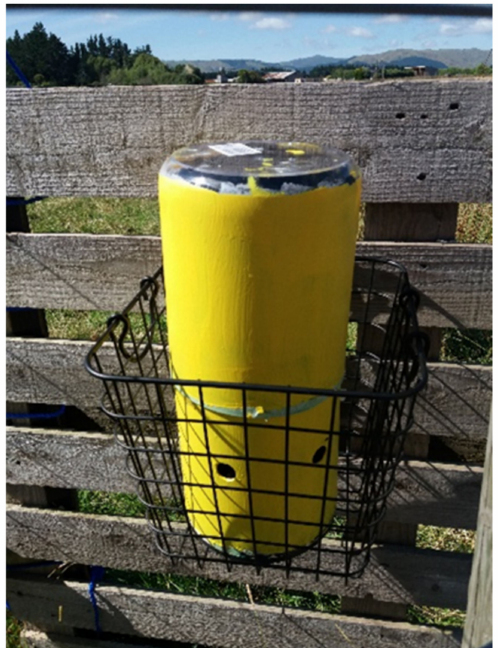
Figure 3. Painted Western Australian Trap in a wire basket at the study